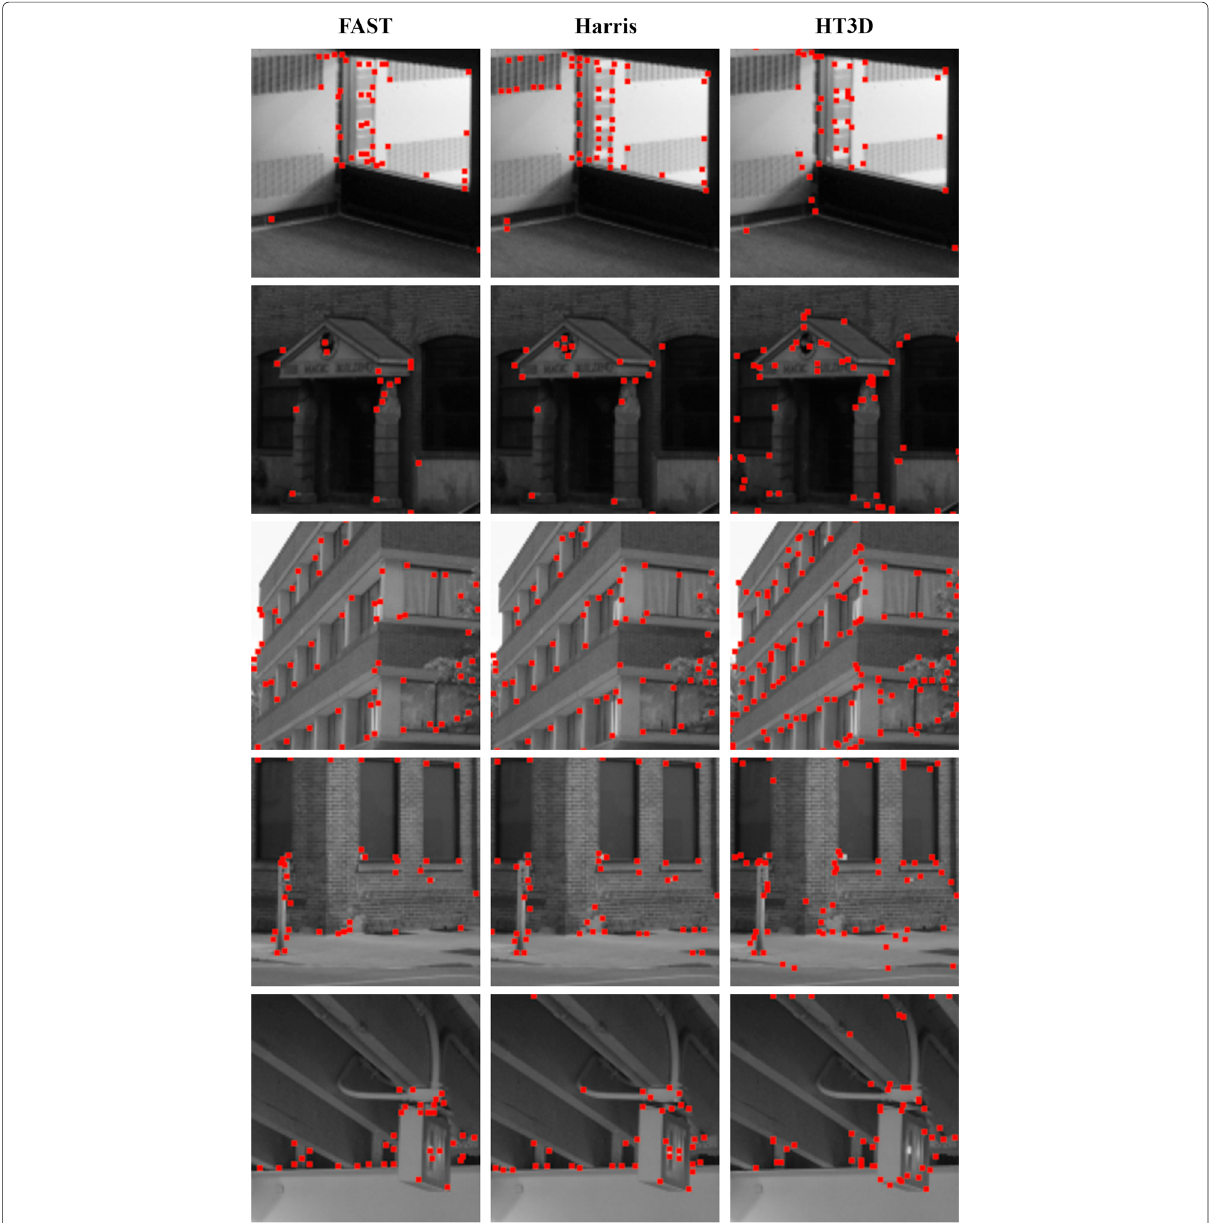
Fig. 15 Zoomed representative regions of the images in Figs. 13 and 14. In this figure, the differences in the detection results of corners and segment endpoints provided by the three methods can be clearly